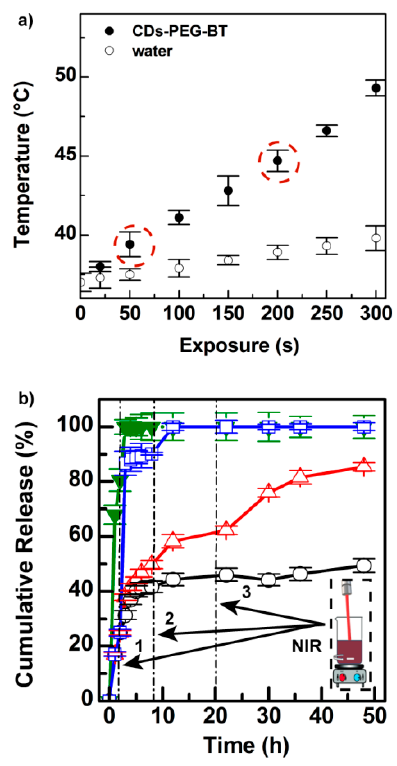
Figure 3. Photothermal kinetics of the CDs-PEG-BT in PBS pH 7.4 (0.5 mg mL − 1 ) ( solid symbol ) compared with pure phosphate buffered saline (PBS) (open symbol) ( a ). Drug release profiles of CDs-PEG-BT/IT in PBS pH 7.4 compared with the diffusion profile of the free IT (green line) at the equivalent concentration ( b ): without 810 nm laser exposure ( black line ), after three cycles of NIR exposure for either 50 s ( red line ) or 200 s ( blue line ) at low power density (2 W cm − 2 ). Release profiles of CDs-PEG-BT/IT in PBS pH 7.4 after three cycles of 810 nm laser exposure for either 50 or 200 s (2 W cm − 2 ).